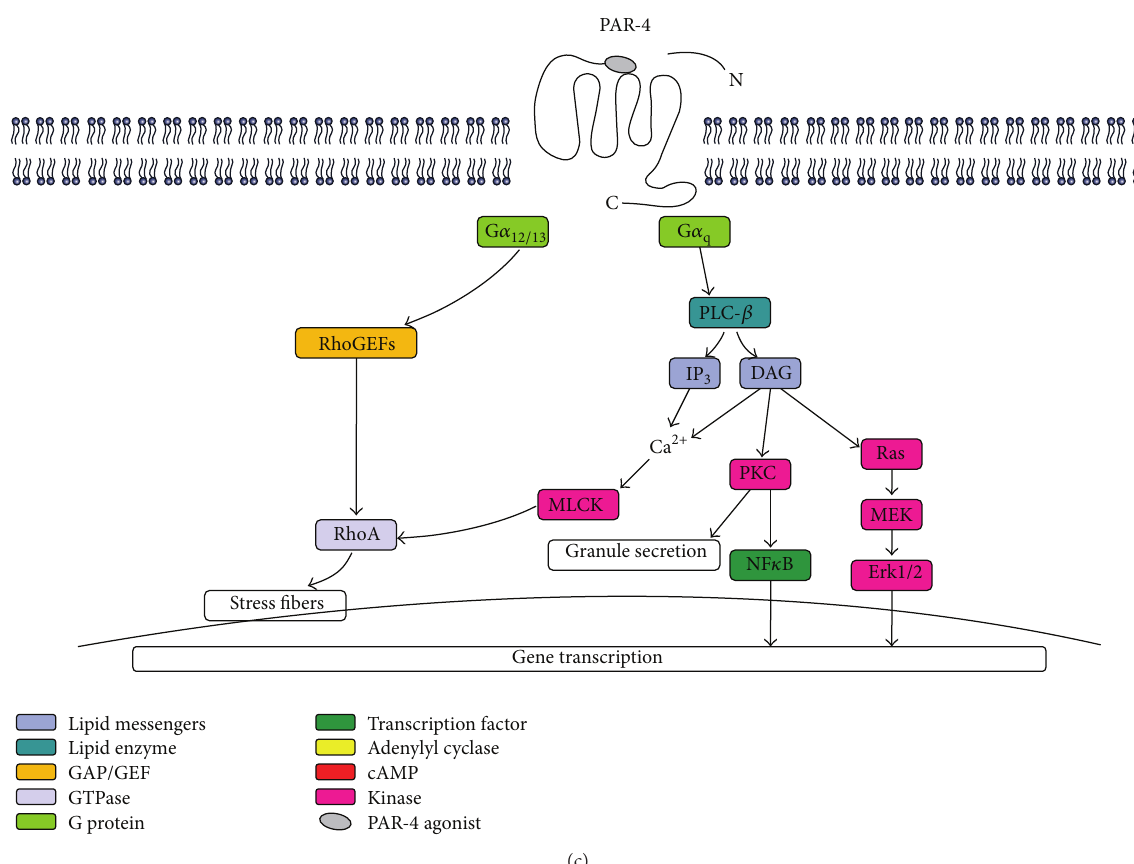
Figure 2: (a) Signal transduction pathways for PAR-1 and PAR-2. (b) Signal transduction pathways for PAR-1 and PAR-3. (c) Signal transduction pathways for PAR-4.